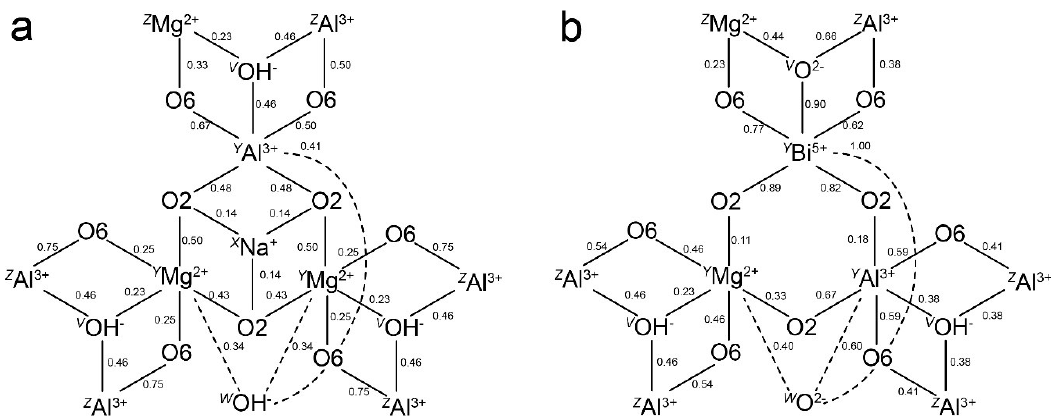
Figure 12. Structural arrangement graph of the Y-site neighborhood in the structure of ( a ) Al-Mg disordered dravite and ( b ) an arrangement derived from it by Bi 5 + (cid:3) V O 2– W O 2 − (Mg 2 + Na 1 + V OH –W OH − ) − 1